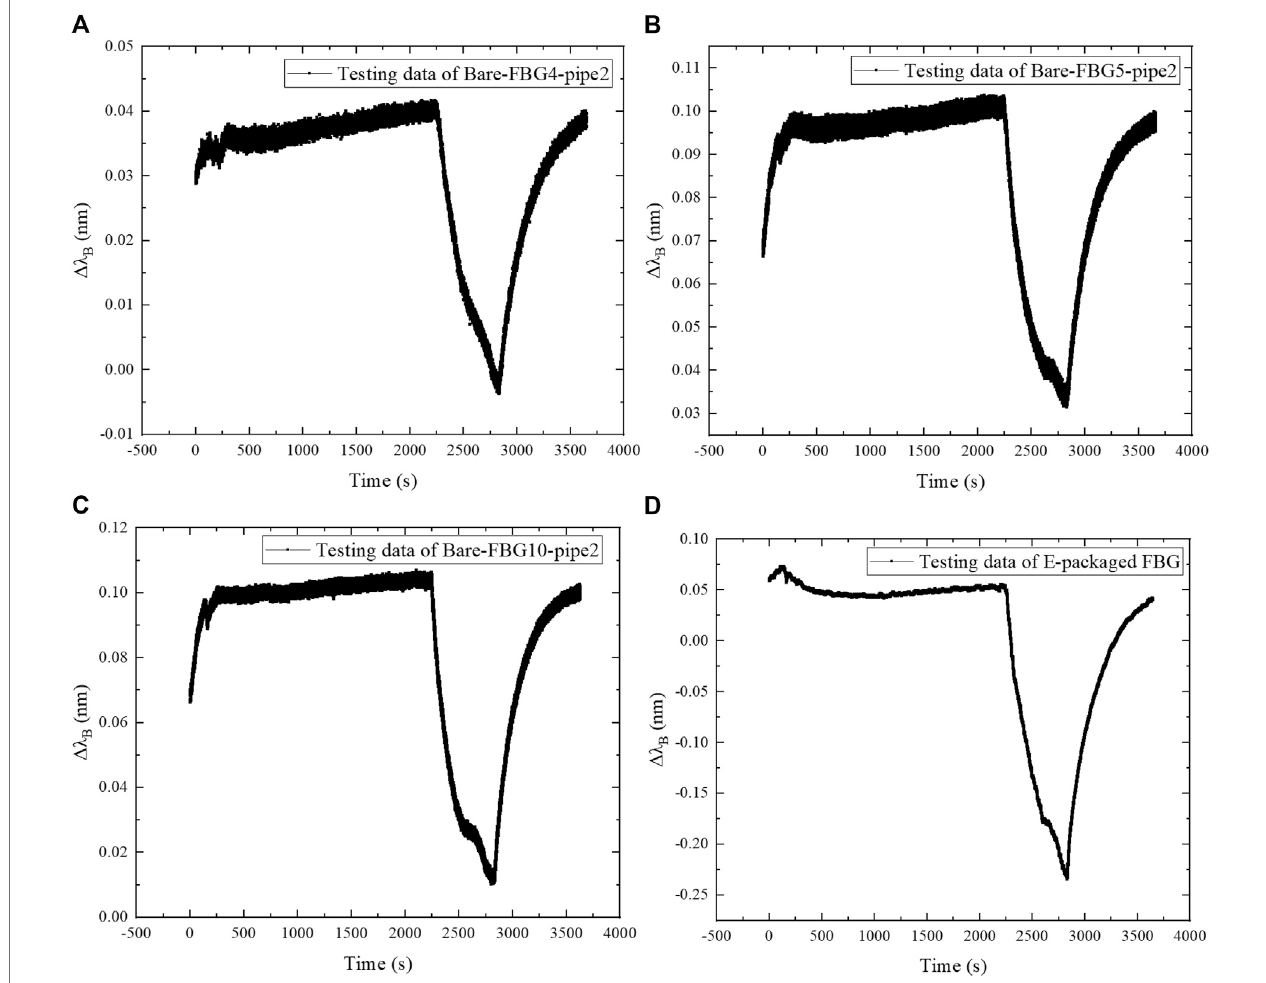
FIGURE 8 | Relationship of central wavelength increment with loading time at 30 Hz: (A) Bare-FBG4-pipe2; (B) Bare-FBG5-pipe2; (C) Bare-FBG10-pipe2; (D) E-packaged FBG.